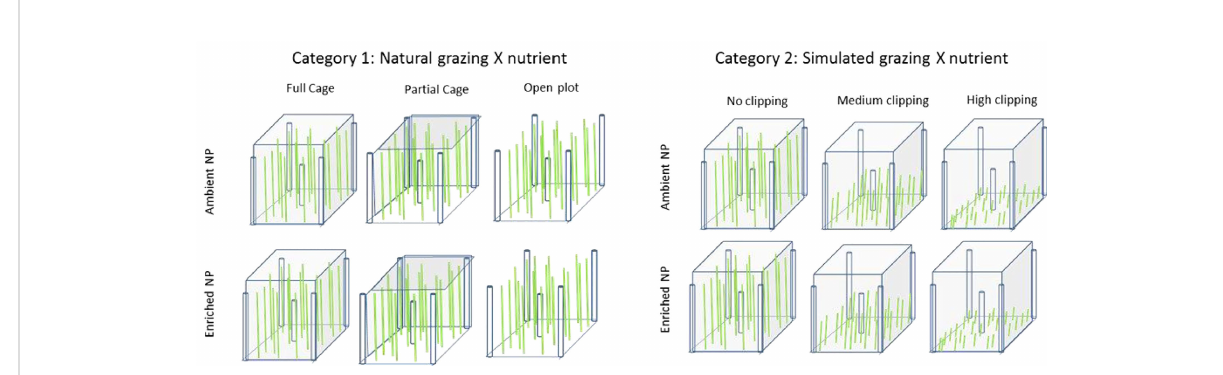
FIGURE 2 Graphical representation of treatments (n=5) established at our study site. Treatments included two broad categories: natural grazing (full cages, partial cages and uncaged plots) x fertilization; and simulated grazing (no clip, half clip and full clip) x